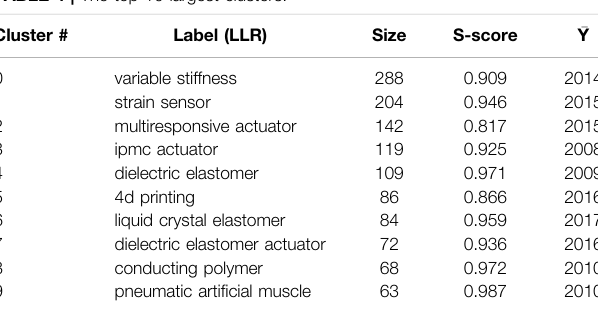
TABLE 4 | The top 10 largest clusters. TABLE 5 | The most cited 10 references by our WoS